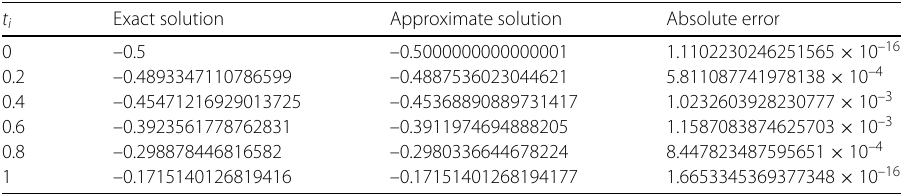
Table 5 The absolute errors of approximating y 1, α for (1,2)-system at various t and α = 0.5